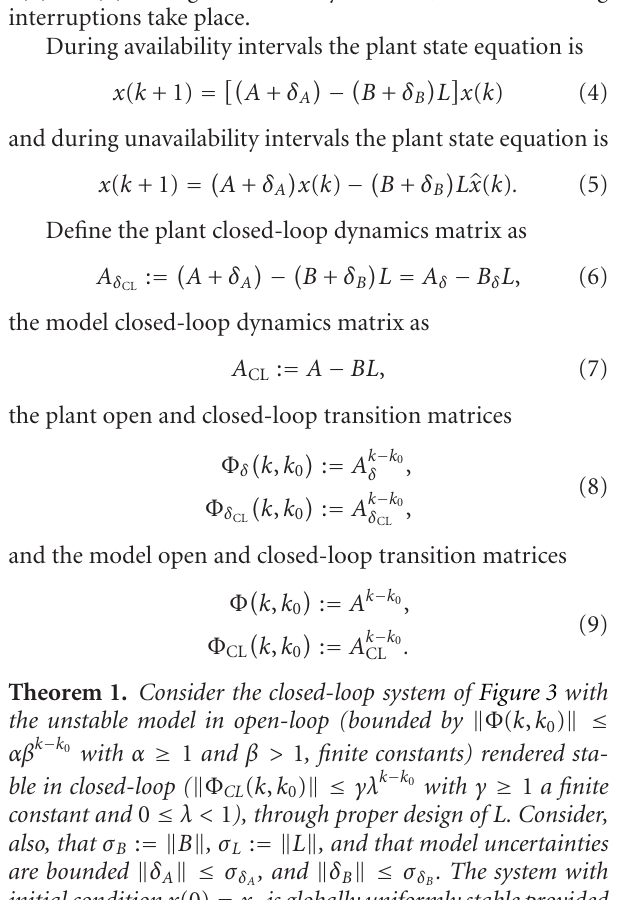
The model initial sate (cid:2) x is made equal to the last available observation of the state x when an interrupted observation occurs ( (cid:2) x ( k 0 ) = x ( k 0 ) = x ( k 0 − 1)), since the sate x is no longer